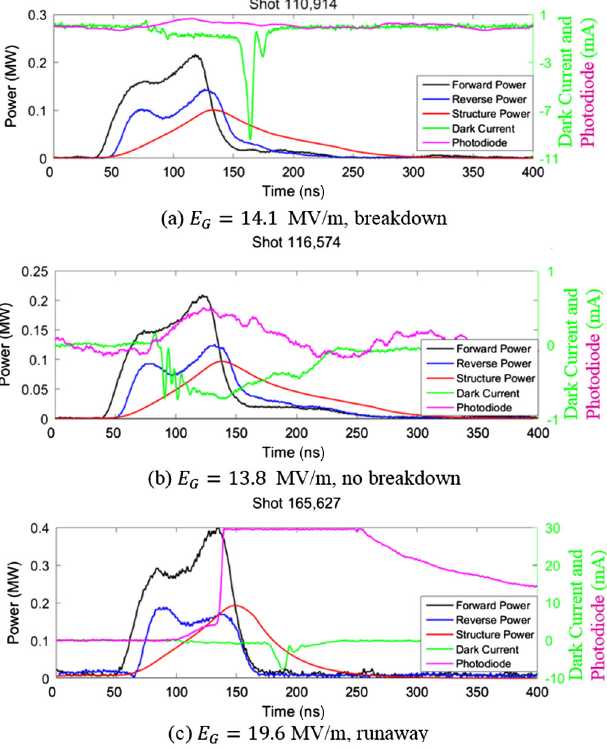
FIG. 27. Typical traces of the forward power, the reverse power, the calculated structure power and the dark current from the downstream Faraday cup for the HPBG-Pin structure (a) during reprocessing, (b) after reprocessing, no breakdown, and (c) for runaway situation of the high power testing of the HPBG-Pin